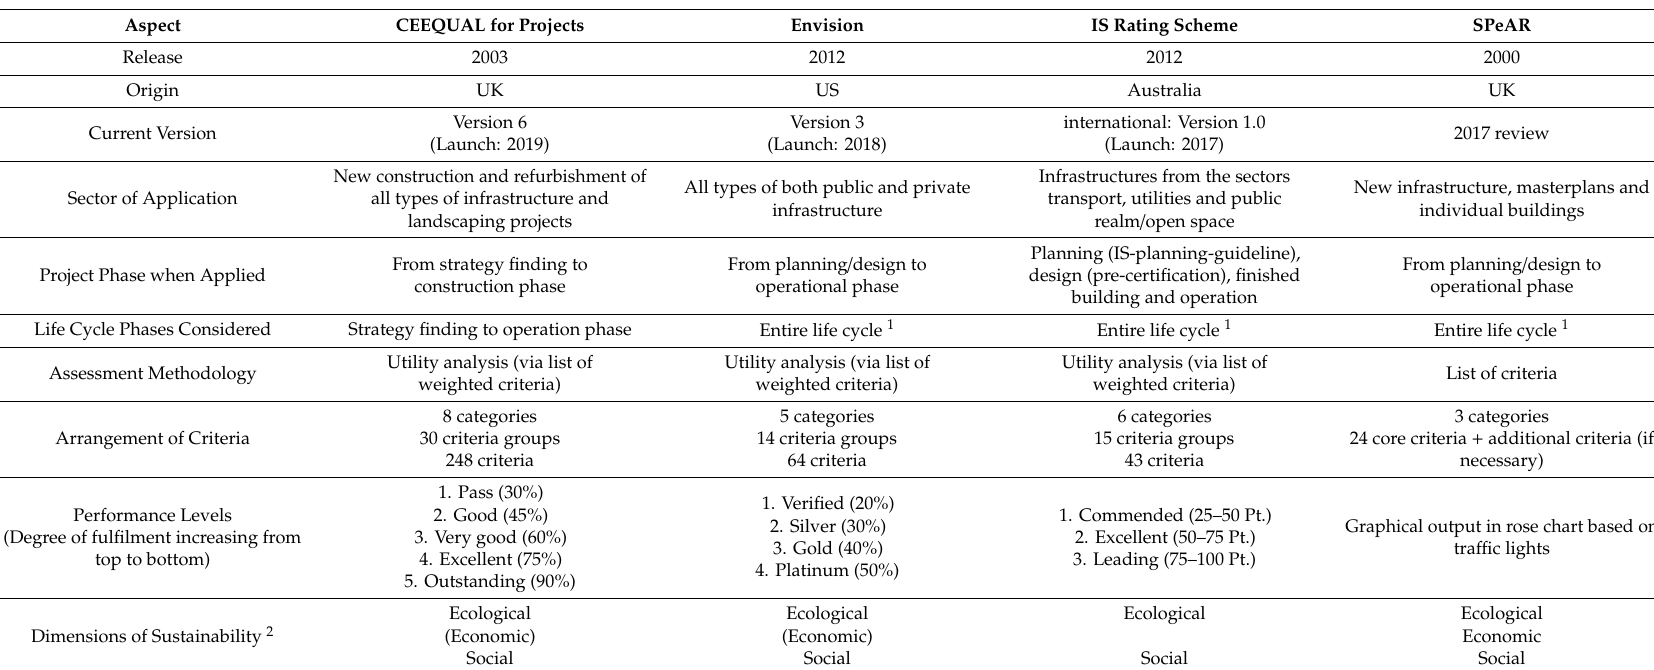
Table 3. Interdisciplinary assessment schemes, applicable to a wide range of infrastructure (based on data from: